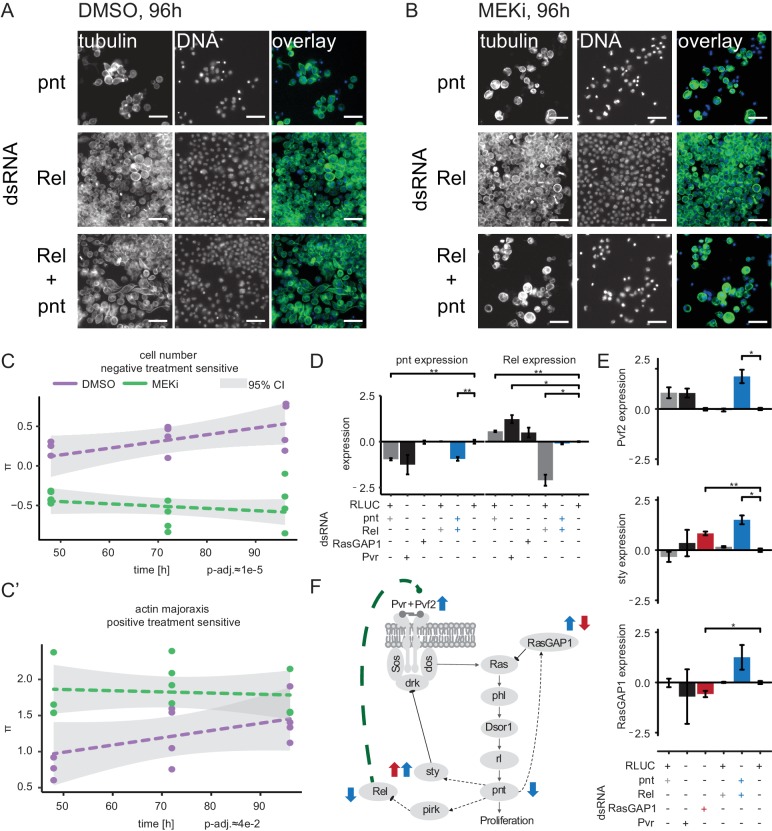
Crosstalk of NF-κB and Ras signaling through Rel and pnt.(A) Upon Rel or Rel/pnt knockdown cells behave normally, growth is inhibited upon pnt knockdown alone. (B) Dsor1 inhibitor treatment attenuated this alleviating interaction. Scale bar = 30 µm. Images are pseudo colored, DNA/DAPI = blue, FITC/α-tubulin = green. (C) Quantified negative treatment-sensitive interaction between Rel and pnt. The trajectory of the MEK inhibitor treatment is lower than the solvent control condition for cell count interaction indicating synthetic lethality under MEK inhibition. (C’) Actin major axis shows a strong positive interaction (cells are enlarged like under pnt knockdown). Error of fit is shown as 95% confidence interval. Dashed lines show trendlines of a treatment wise model fit. (D, E) Expression of candidate and marker genes assessed by qPCR (3 days RNAi treatment, n = 3, log2 foldRLUC, mean ±s.e.m., t-test) on S2 cells. (D) pnt expression is reduced upon pnt and Pvr knockdown. Rel knockdown does not rescue pnt expression. Rel expression is increased upon pnt and Pvr knockdown and decreased upon Rel knockdown. Upon pnt and Rel knock down, Rel expression is rescued to normal levels. (E) Pvf2 expression is induced only upon Rel/pnt double knockdown. This leads to increased expression of sty and RasGAP1. RasGAP1 knockdown increases sty expression and decreases RasGAP1 expression. (D–E) *=p < 0.05, **=p < 0.01. (F) A model summarizes the qPCR results in context of the Ras signaling cascade. Dashed lines are transcriptional interactions, solid lines are protein-protein interactions. All black interactions are known, while the green interaction is inferred from the data. Blue arrows indicate that Pvf2, sty and RasGAP1 were upregulated upon Rel/pnt co-knockdown and by that Ras pathway activity was restored. A similar pattern could be observed upon RasGAP1 knockdown, which causes intrinsic hyper-activation of Ras signaling by constitutive Ras activation (measured by upregulation of sty, red arrows).